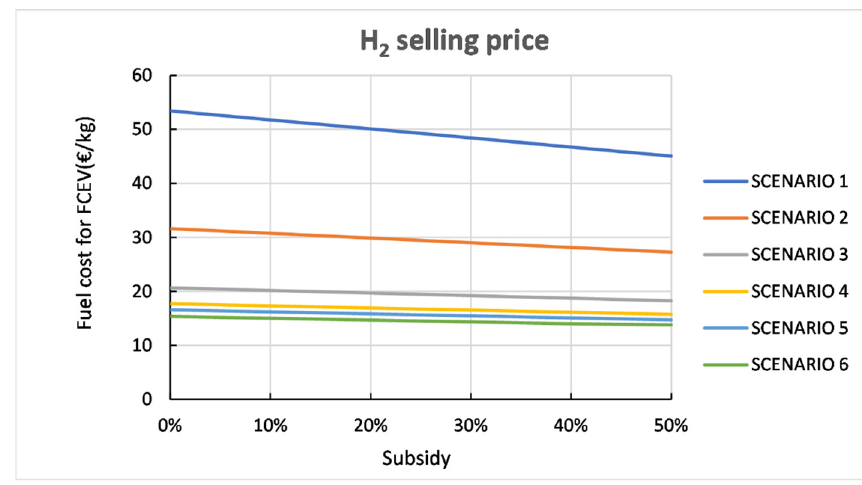
Figure 11. Effect of subsidy on the final selling price of H 2 .